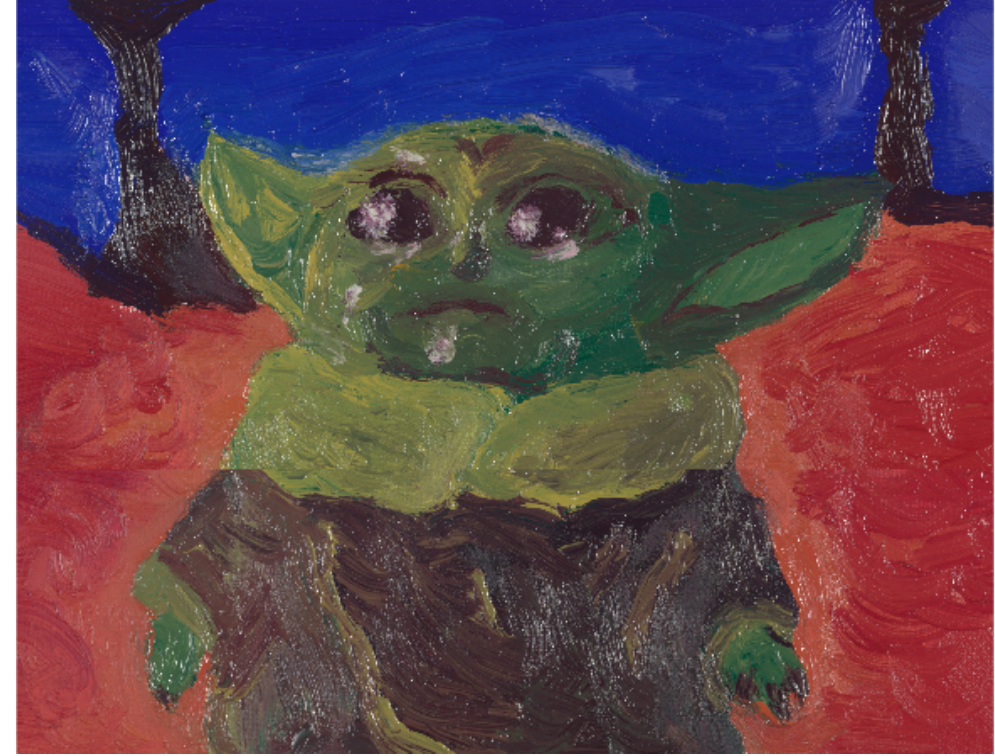
Figure 3. Mockup painting realised with the same set of pigments used for the composition of the mixture samples. Reproduced from [47] with permission from the